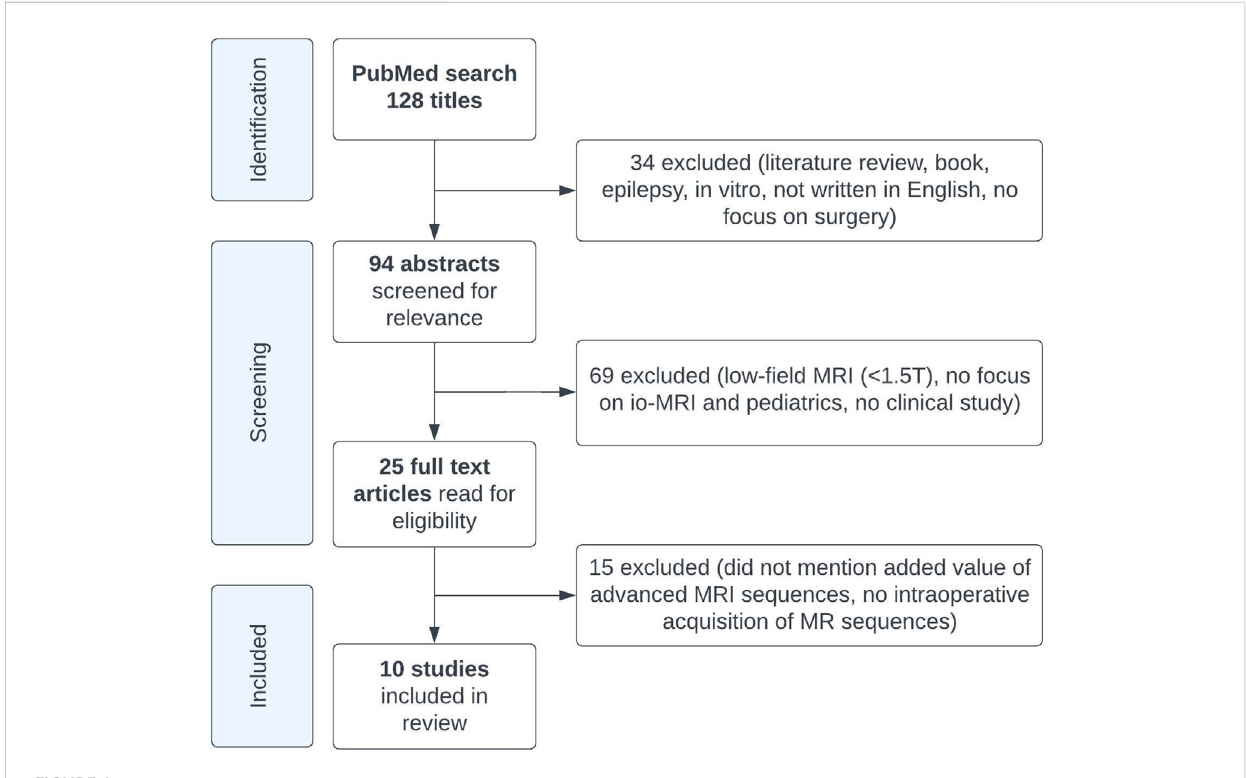
FIGURE 1 Study fl